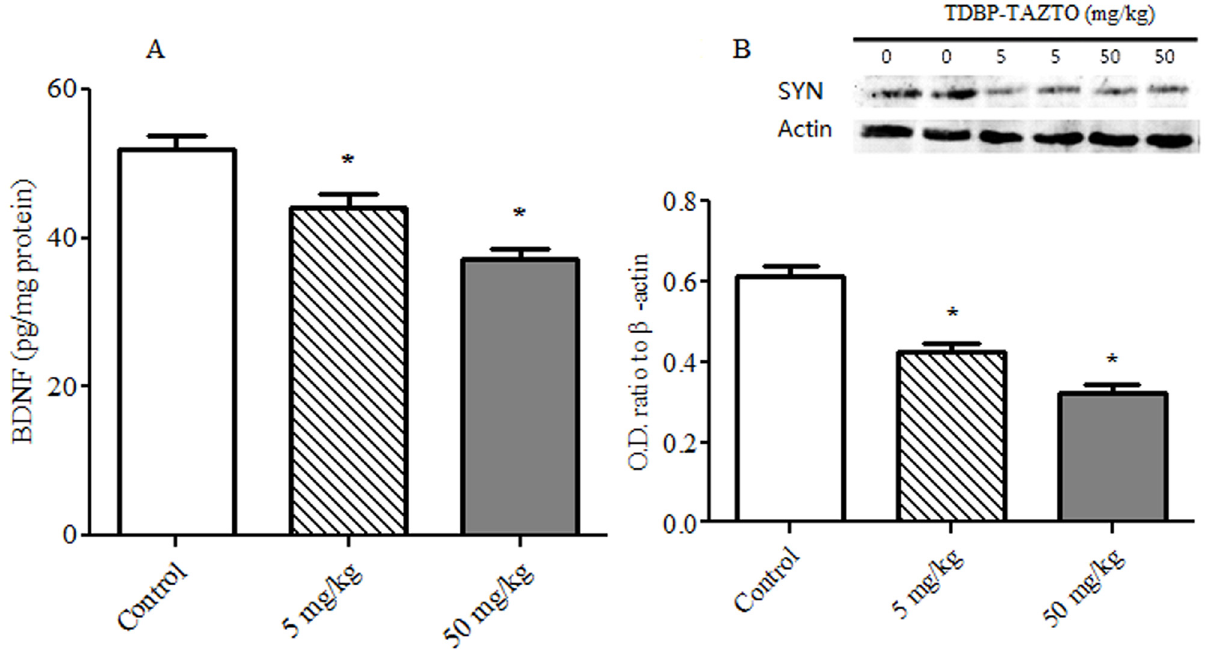
Fig 7. The effects of TDBP-TAZTO (5 and 50 mg/kg) on BDNF and SYP expression in hippocampus. The results are presented as mean ± SE (n = 5/ group). * p < 0.05, vs. control group. BDNF (A) was expressed as pg/mg protein. The O.D. values were displayed in SYP (B) normalized to β -actin.